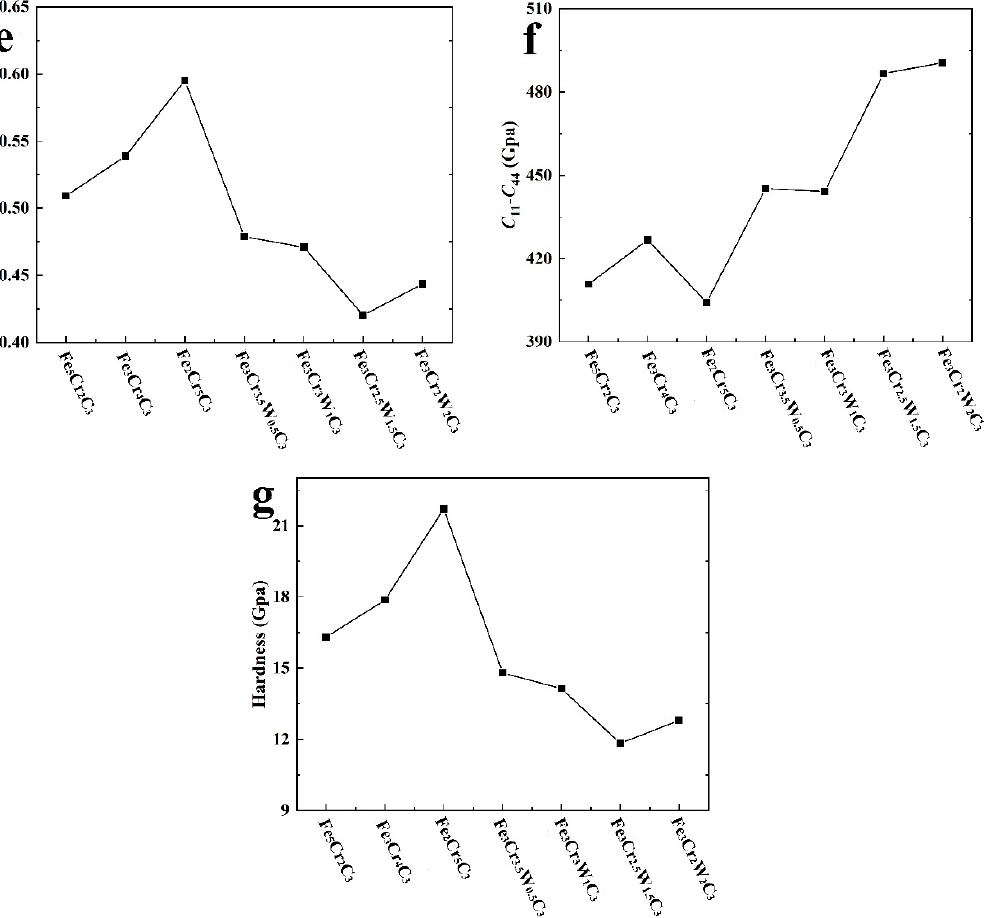
Figure 3. The mechanical properties of M 7 C 3 : ( a ) the bulk modulus (B); ( b ) the shear modulus (G); ( c ) Young’s modulus (E); ( d ) Poisson’s ratio ( σ ); ( e ) Pugh’s modulus ratio G/B; ( f ) Cauchy pressure C 12 – C 44 ; ( g ) calculated hardness. Table 2. The elastic constants ( C ij , GPa) of different M 7 C 3 carbides.